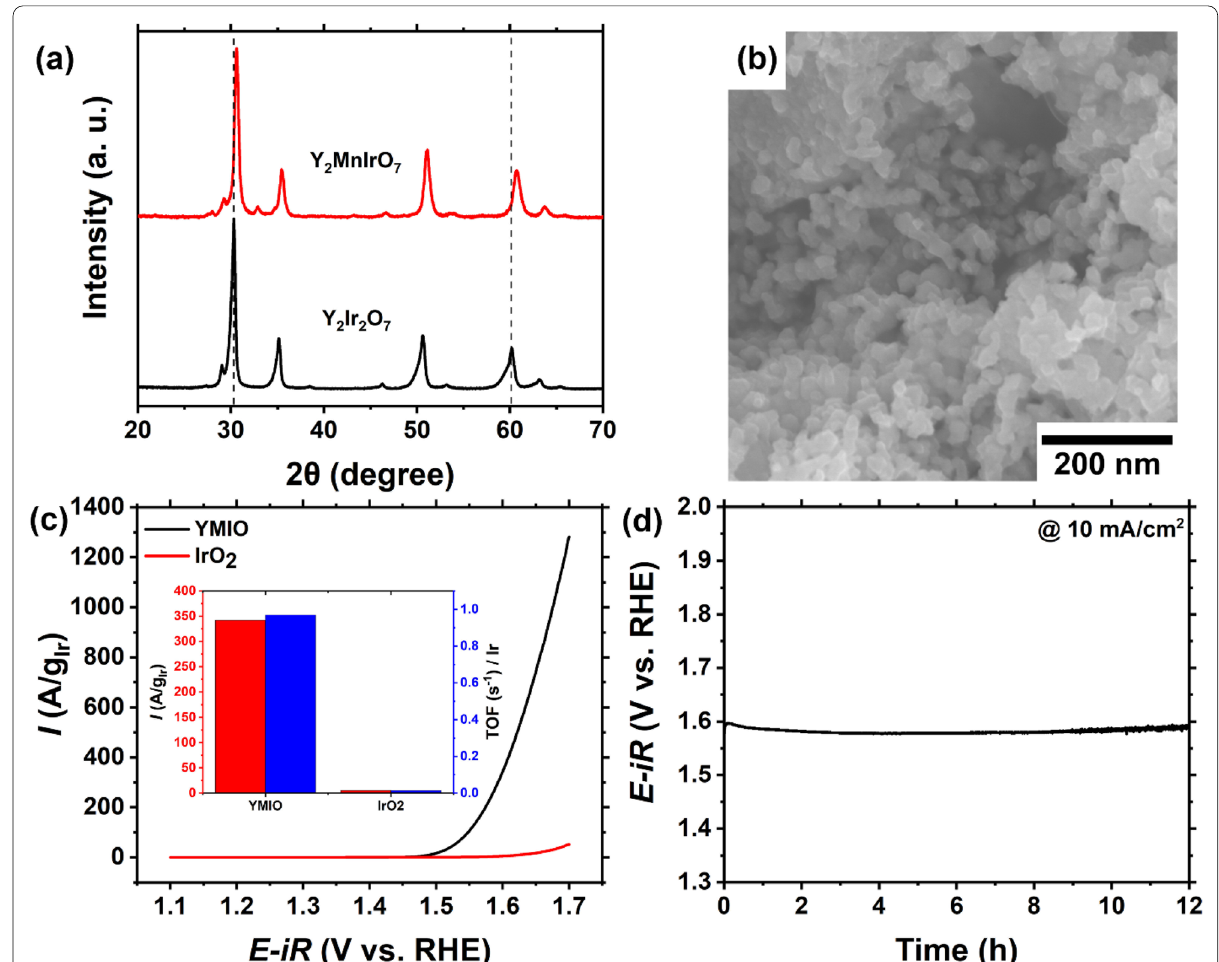
Fig. 8 a XRD pattern, b SEM image of YMIO, c OER activity of YMIO and IrO 2 , the inset shows the comparison of current densities and TOF at 1.60 V versus RHE for YMIO and IrO 2 . d Chronopotentiometry of YMIO under constant current density of 10 mA/cm 2 electrode up to 12